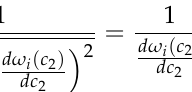
(cid:107) from ∂ω i